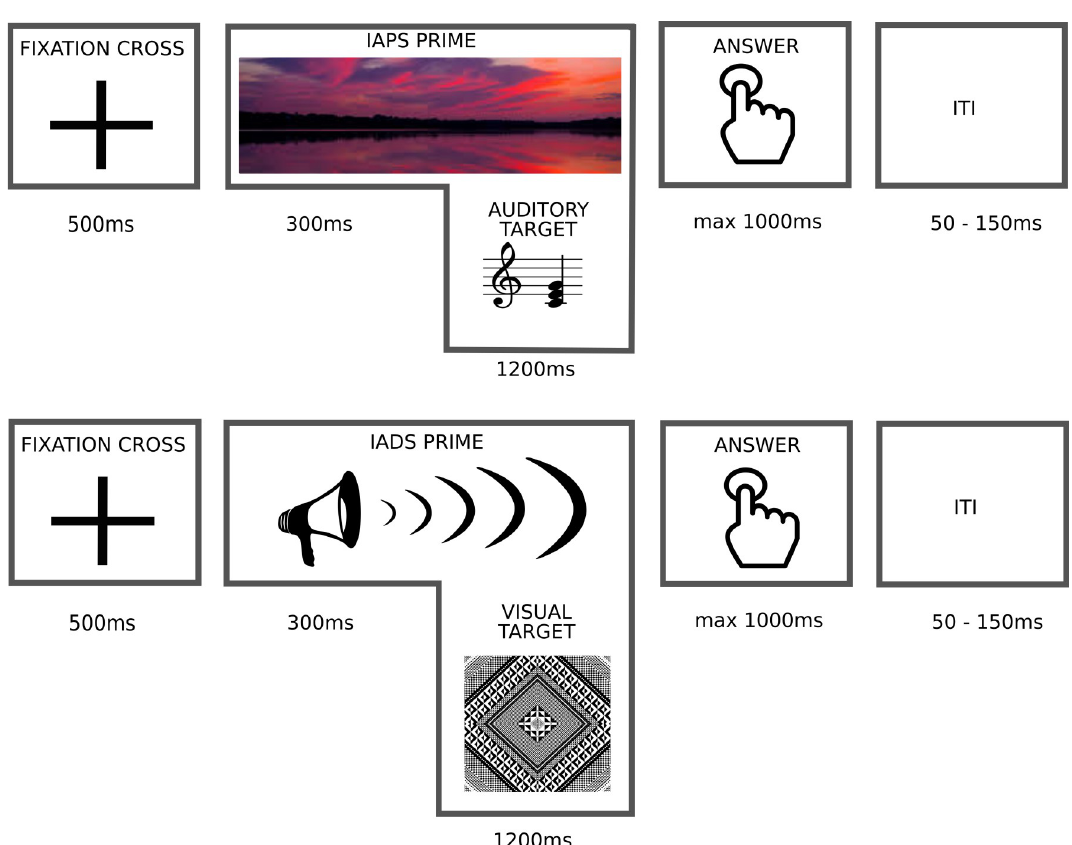
Fig 1. Trial structure for both types of prime-target pairs. Upper diagram: A single trial of the condition 1 with a visual prime and acoustic target. Lower diagram: A single trial of the condition 2 with an acoustic prime and visual target.